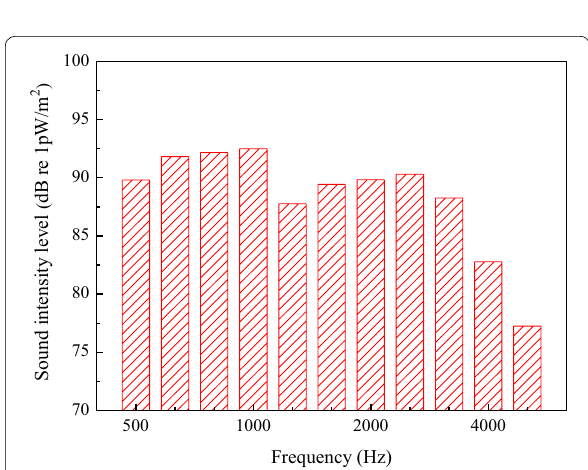
Figure 26 Average sound intensity spectrum of the exterior sidewall